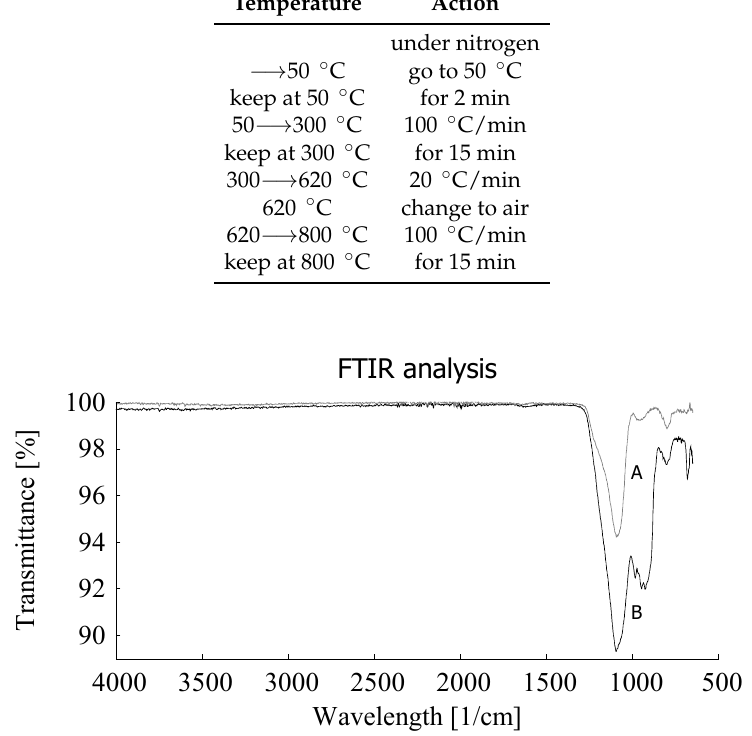
Figure 3. FTIR analysis of silica ( A ) as reference and ash of devulcanizate after TGA ( B ).